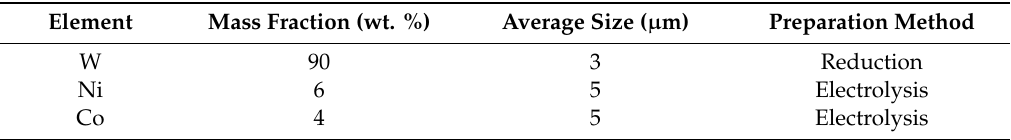
Table 1. Characteristics and mass fraction of W, Ni, and Co powders.